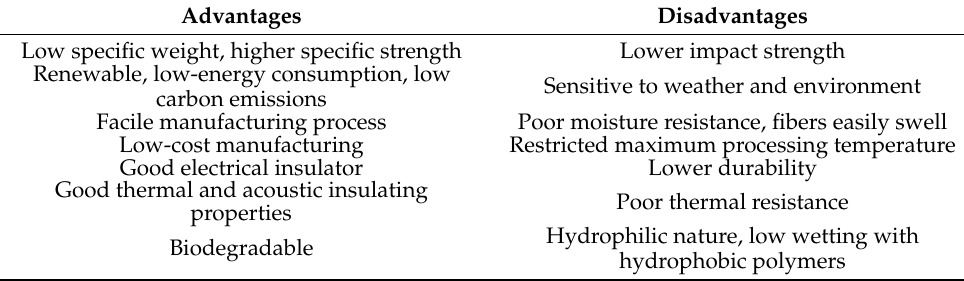
Table 2. Advantages and disadvantages of natural